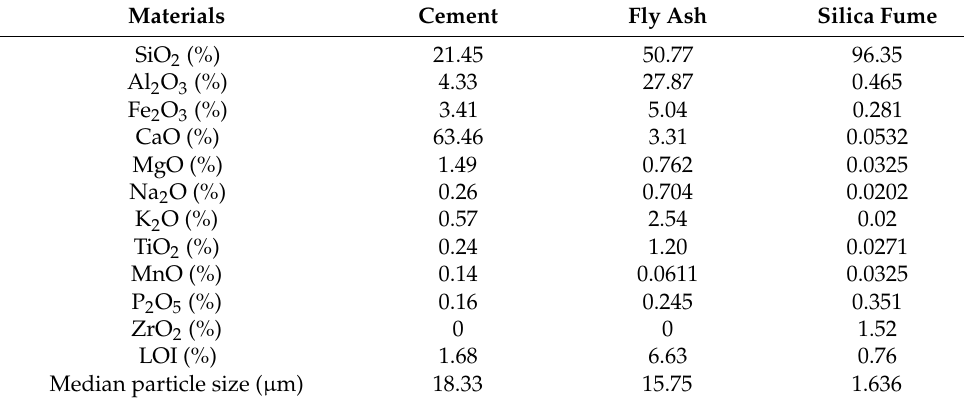
Table 1. Chemical composition of cement, FA, and SF.